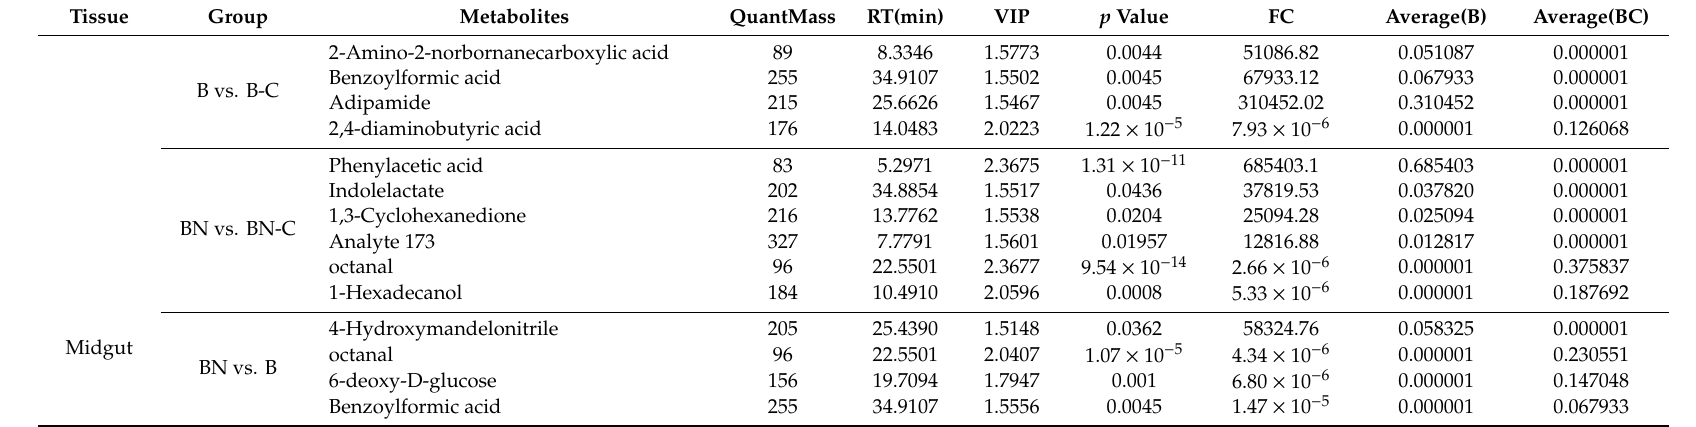
Table 3. Specific metabolites from midgut tissues of di ff erent